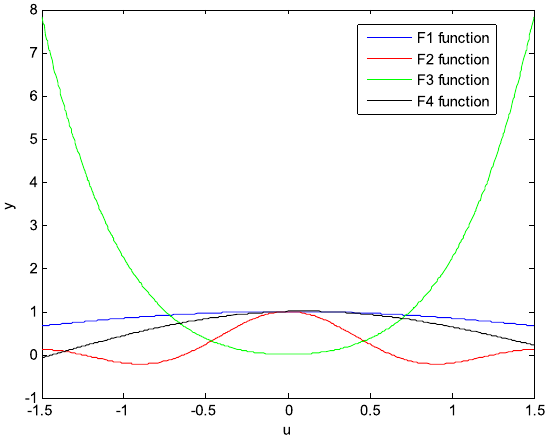
Fig. 3. Four functions in